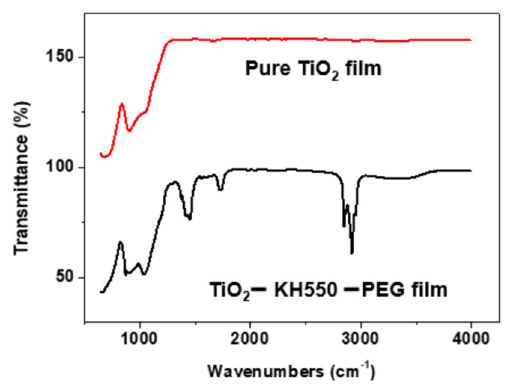
Figure 3. FT-IR spectra of pure TiO 2 film and TiO 2 –KH550–PEG composite film.